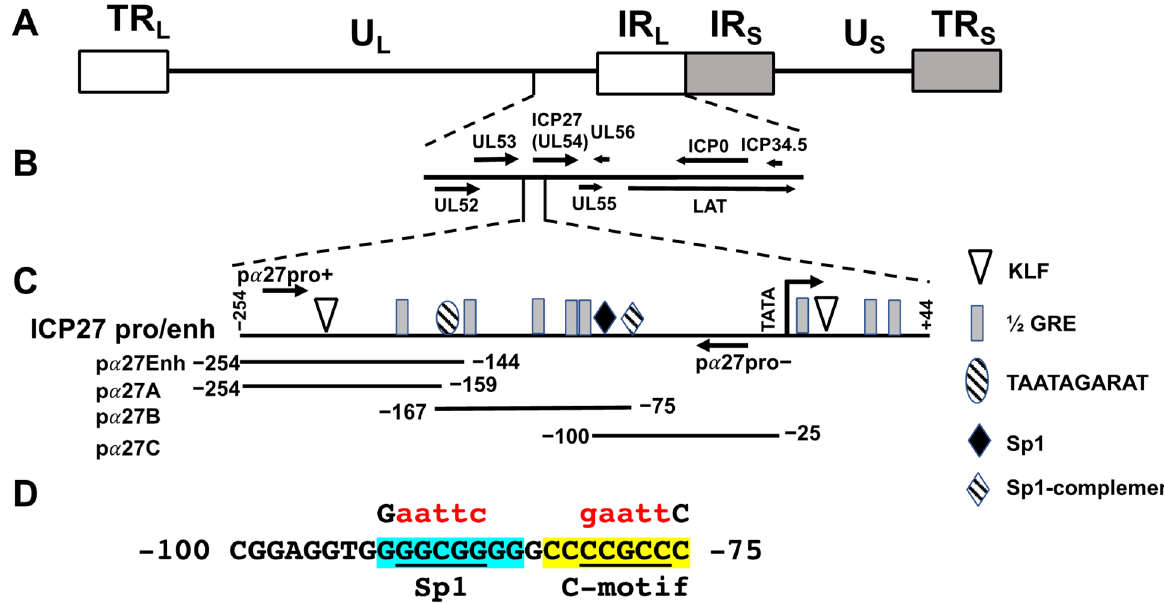
Figure 1. Location of ICP27 gene and promoter within the unique long region of the HSV-1 genome. Panel ( A ): Schematic of HSV-1 genome. Unique long (U L ) and unique short (U S ) segments are flanked by the long repeats (R L : white rectangles) and short repeats (R S : gray rectangles). Repeats are denoted as terminal (T) or internal (I). Panel ( B ): Location of ICP27 (UL54) gene in U L is shown, along with flanking genes in U L and R L . Panel ( C ): Schematic of ICP27 promoter, with potential transcription factor binding sites relative to the starting site of transcription (arrow): ½ GREs (grey rectangle), potential KLF binding sites (white triangle), Sp1 binding site (black diamond), and TAATAGARAT motif (striped oval). Four enhancer fragments (p α 27Enh, − 254 to − 144; p α 27A, − 254 to − 159; p α 27B, − 167 to − 75; p α 27C, − 100 to − 25) used in this study are shown. These fragments were cloned upstream of pGL4.24[luc2/minP] firefly luciferase reporter plasmid (Promega; Madison, WI, USA). Positions of p α 27 pro+ and − PCR primers are indicated. These primers yield a 191 bp PCR product. Panel ( D ): Shared nucleotides of p α 27B and p α 27C fragments ( − 100 to − 75). Sp1 binding site (blue highlighted bases) and C-rich motif containing Sp1 complementary site (yellow highlighted bases) are indicated. Mutated bases are in red and underlined in wt sequences.